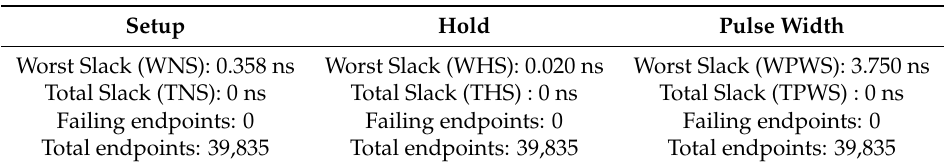
Table 4. Design timing